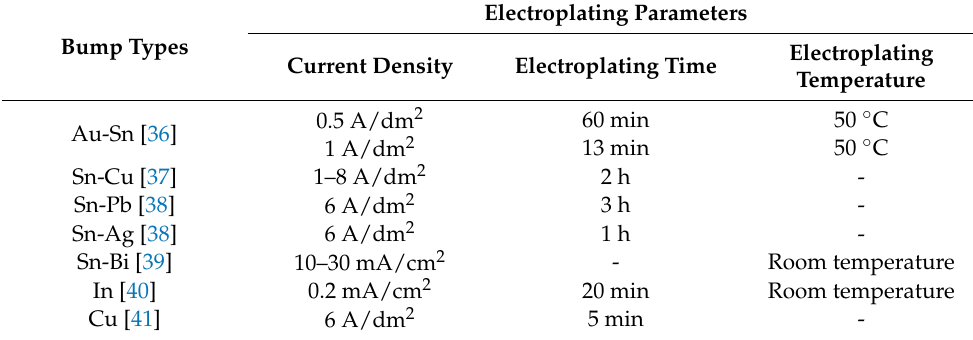
Table 1. Bump types and electroplating